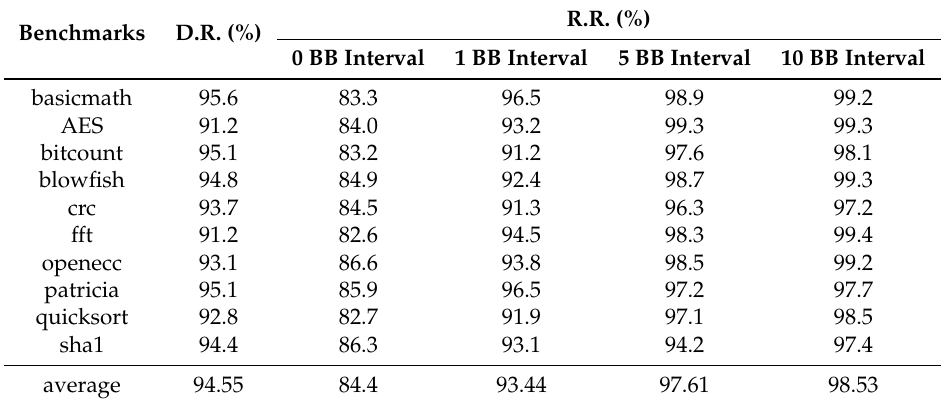
Table 2. Detection and recovery rating for tampering with the indirect jump instruction.